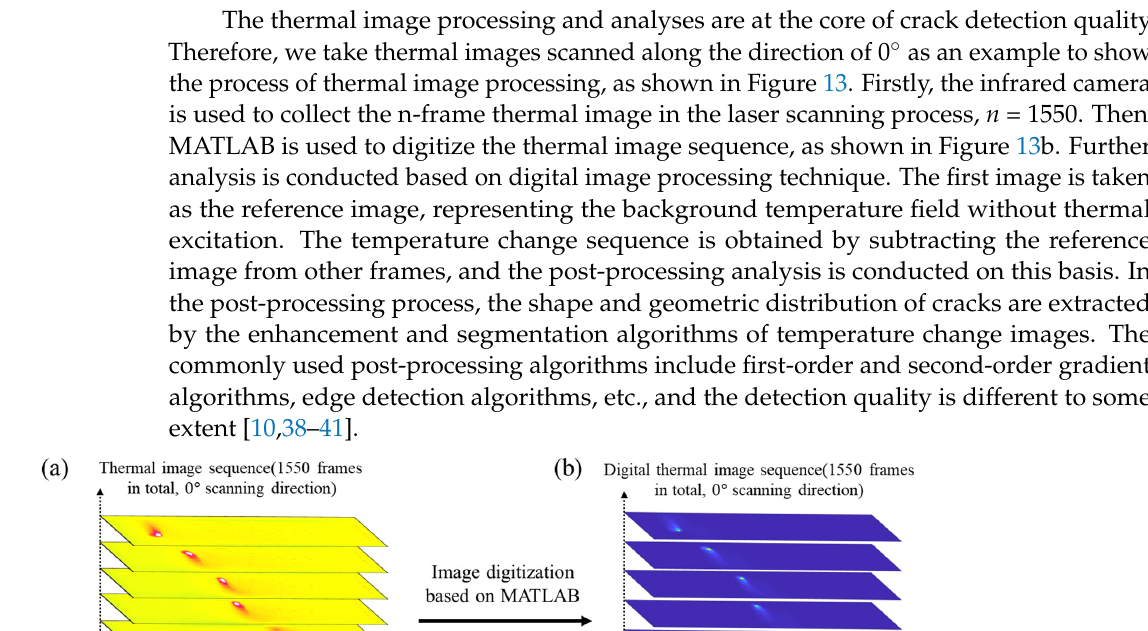
Table 4. Comparison of two post ‐ processing algorithms.